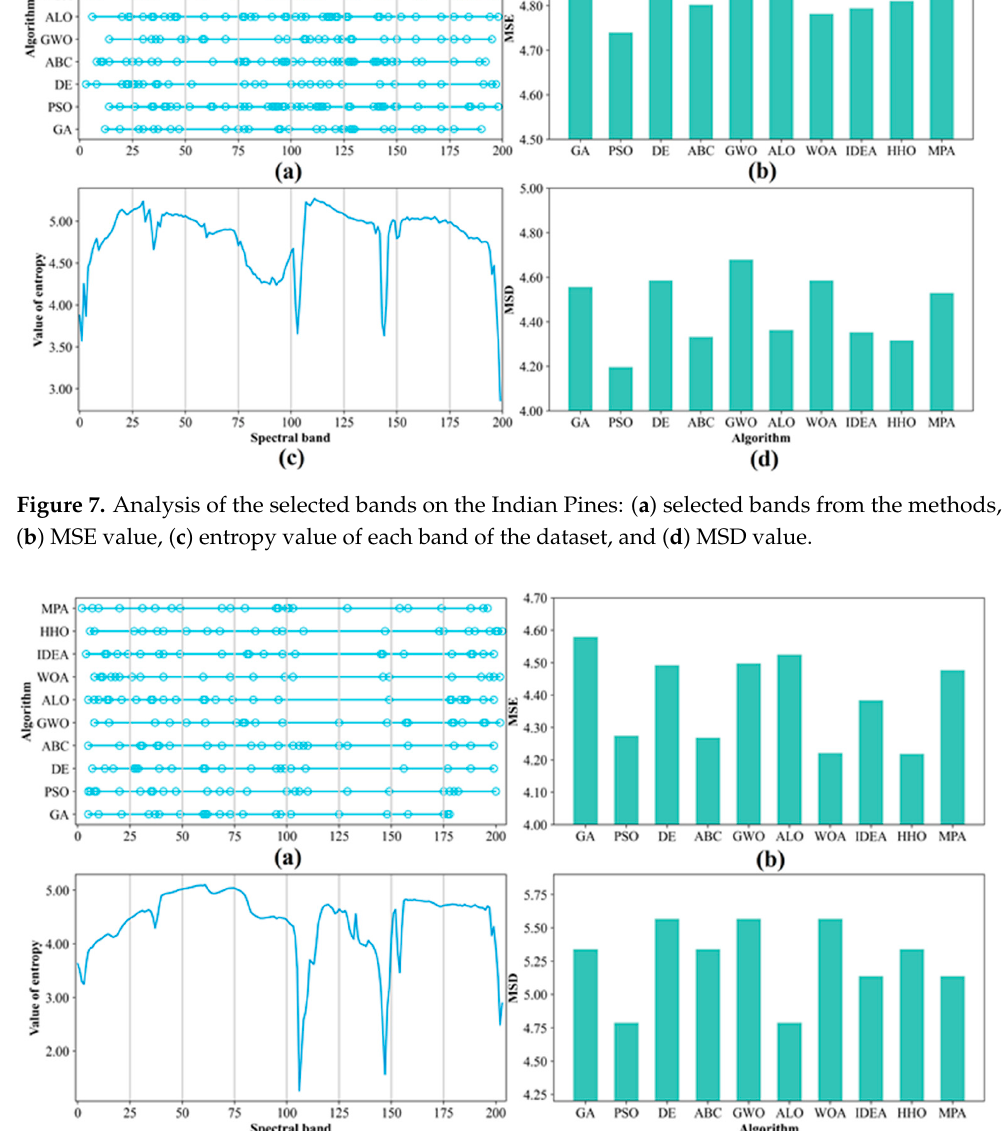
Figure 7. Analysis of the selected bands on the Indian Pines: ( a ) selected bands from the methods, ( b ) MSE value, ( c ) entropy value of each band of the dataset, and ( d ) MSD value.